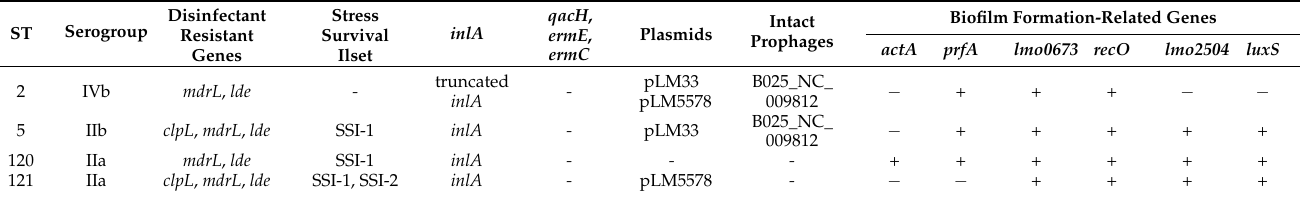
Figure 1. The distribution of the four STs in two RTE food processing plants in this study. ( A ): The distributions of four STs in plant A in 2019. ( B ): The distribution of four STs in plant B in 2019. ( C ): The distribution of four STs in plant A in 2020. ( D ): The distribution of four STs in plant B in 2020. Different colors represent different proportions of different ST. Table 1. Genetic features of four STs L. monocytogenes from the two RTE meat food processing plants from 2019 to